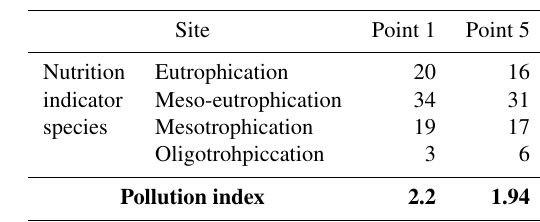
Table 2. Nutrition index number and pollution index of the phyto-